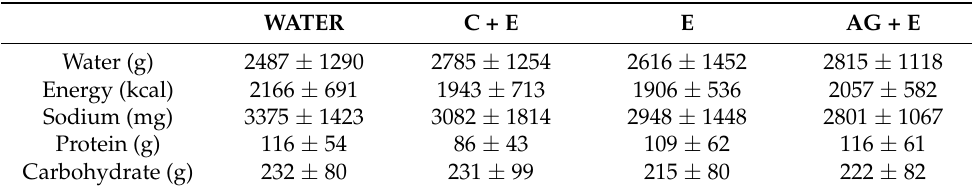
Figure 1. Schematic of the Beverage Hydration Index test protocol performed for each beverage trial ( n = 4). Table 3. Mean ( ± SD) 24 h dietary records prior to each beverage hydration index trial ( n = 19). None of the nutrient intakes were different ( p > 0.05) by